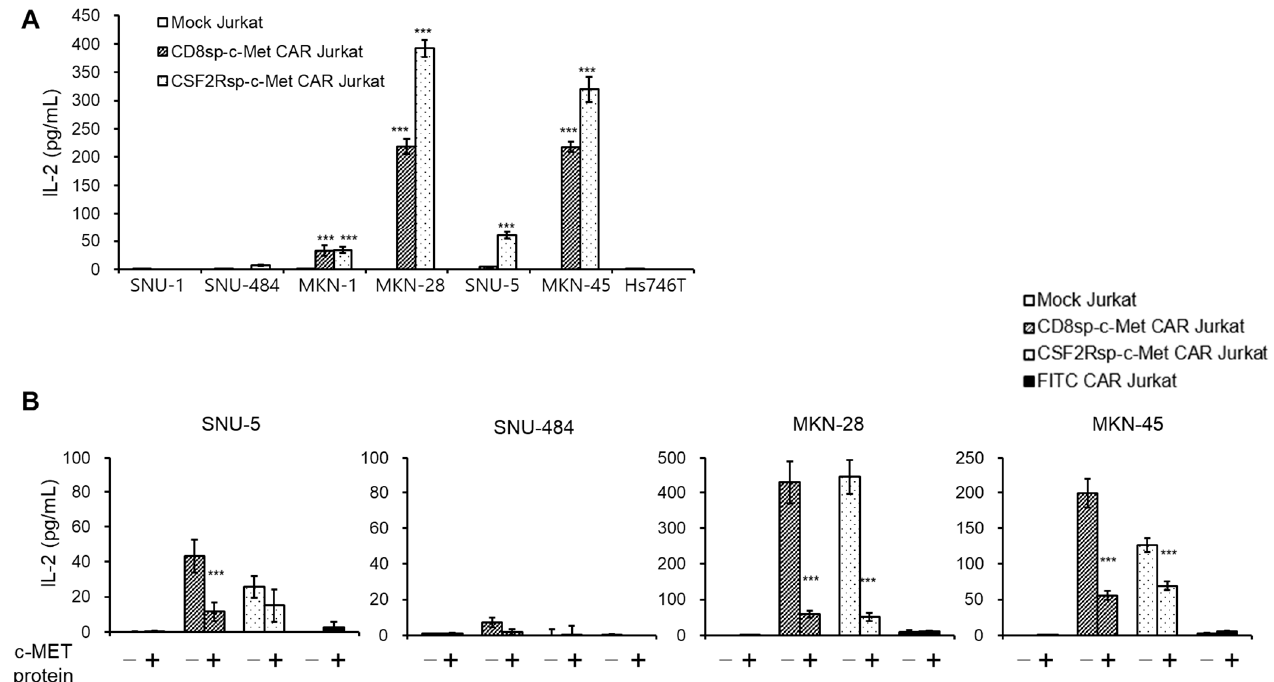
Figure 3. c-Met CAR Jurkat specifically recognizes the c-Met positive GC cells. ( A ) The mock CD8sp-c-Met CAR, or CSF2Rsp-c-Met CAR Jurkat cells (1.5 × 10 5 cells) were co-cultured with GC cell lines (1 × 10 4 cells) at an E:T ratio of 15:1. After overnight incubation, supernatants were collected and ELISA was performed to measure IL-2 level. The bars show mean ± S.D. of experiments performed in triplicate. Statistical analysis was performed by the paired t -test. *** p ≤ 0.01, compared with the mock Jurkat group. ( B ) The mock CD8sp-c-Met CAR, CSF2Rsp-c-Met CAR, or FITC CAR Jurkat cells were co-cultured with GC cell lines in the presence or absence of purified soluble c-MET protein. The next day, supernatants were collected and IL-2 ELISA was performed. The bars show mean ± S.D, of experiments performed in triplicate. Statistical analysis was performed by the paired t -test. *** p ≤ 0.01, compared with the c-Met absence group.